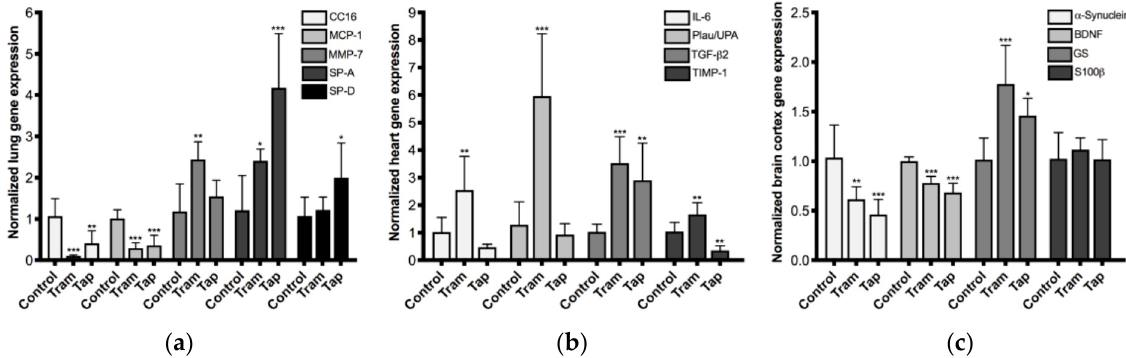
Figure 3. Normalized gene expression levels of lung ( a ), heart ( b ) and brain cortex ( c ) toxicity biomarkers, upon Wistar rat repeated daily intraperitoneal (i.p.) administration of 50 mg/kg tramadol (Tram) or tapentadol (Tap), for 14 consecutive days. Expression levels were normalized against the respective 18S ribosomal RNA (18S rRNA) gene expression, and then against the respective controls (administered with normal saline), set as 1. Results are expressed as means ± SD. *** p < 0.001, ** p < 0.01, * p < 0.05. BDNF: brain-derived neurotrophic factor; CC16: Clara cell protein-16; GS: glutamine synthetase; IL-6: interleukin-6; MCP-1: monocyte chemoattractant protein-1; MMP-7: matrix metalloproteinase-7; Plau/UPA: plasminogen activator, urokinase; S100 β : S100 calcium binding protein B; SP-A: pulmonary surfactant protein A; SP-D: pulmonary surfactant protein D; TGF- β 2: transforming growth factor- β 2; TIMP-1: tissue inhibitor of